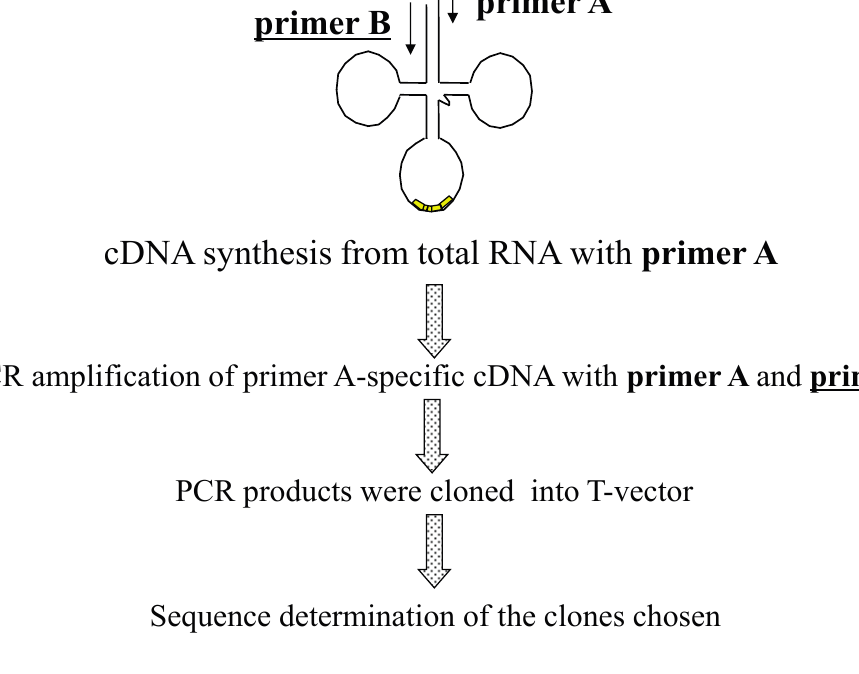
Figure 1. Overall strategy used to confirm predicted tRNA molecules in A. pernix